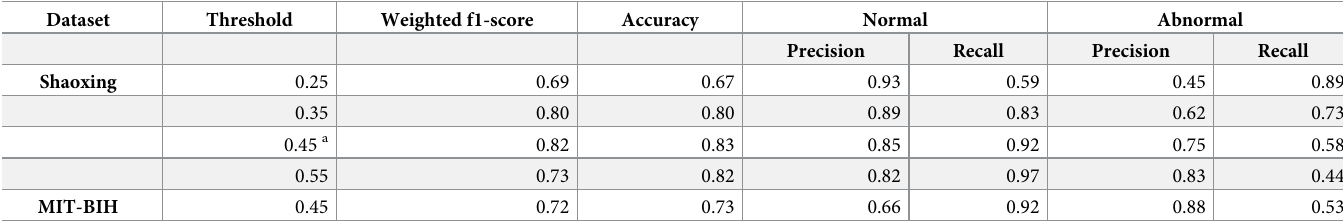
a The threshold with the highest micro f1-score was selected as the criteria for abnormal electrocardiograms. When thresholds with the same f1-score were present, the threshold with the highest precision was